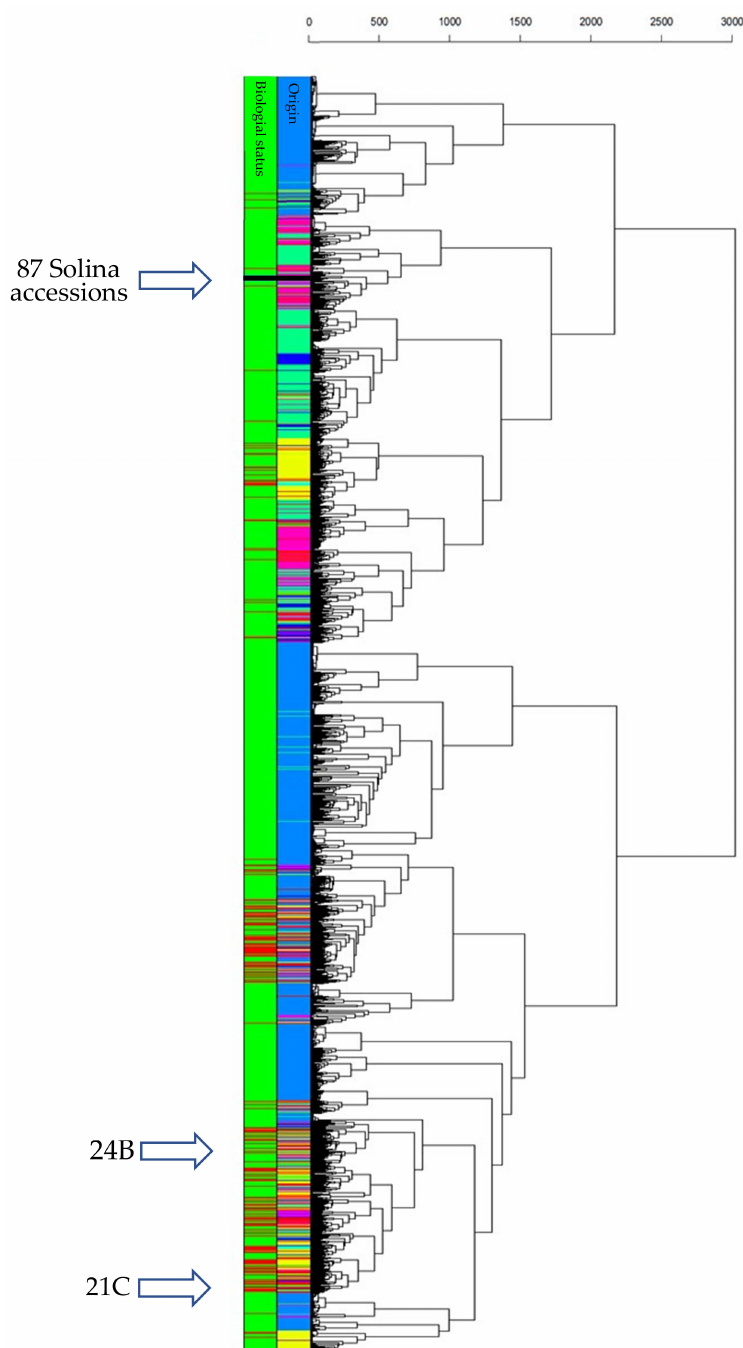
Figure 4. HCA based on Euclidean distances and average-linkage agglomeration method computed by using CIMMYT/Solina dataset (3842 markers and 24,868 genotypes of which 91 were Solina seeds). Two rows of labels indicate wheat origin (95 colors for each country: dodger blue for Mexico, spring green for Iran, deep pink for Turkey, yellow for China, black for Solina) and biological status (green for CIMMYT landraces; red for CIMMYT cultivars; black for Solina